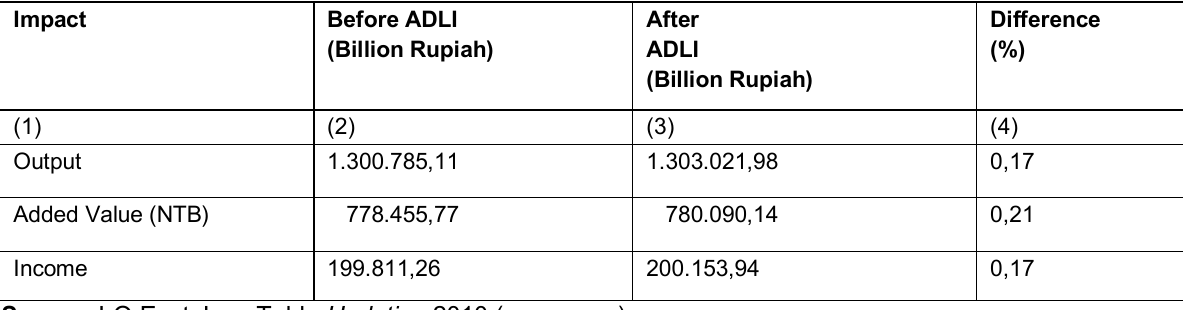
Table 3: The impact of total output, Added Value (NTB), and income before and after ADLI simulation of Impact Before ADLI